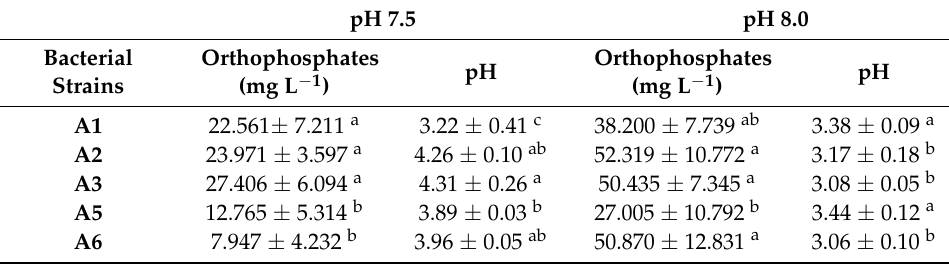
Table 2. Phosphate solubilization by PSB in alkaline pH regions after 8 days of